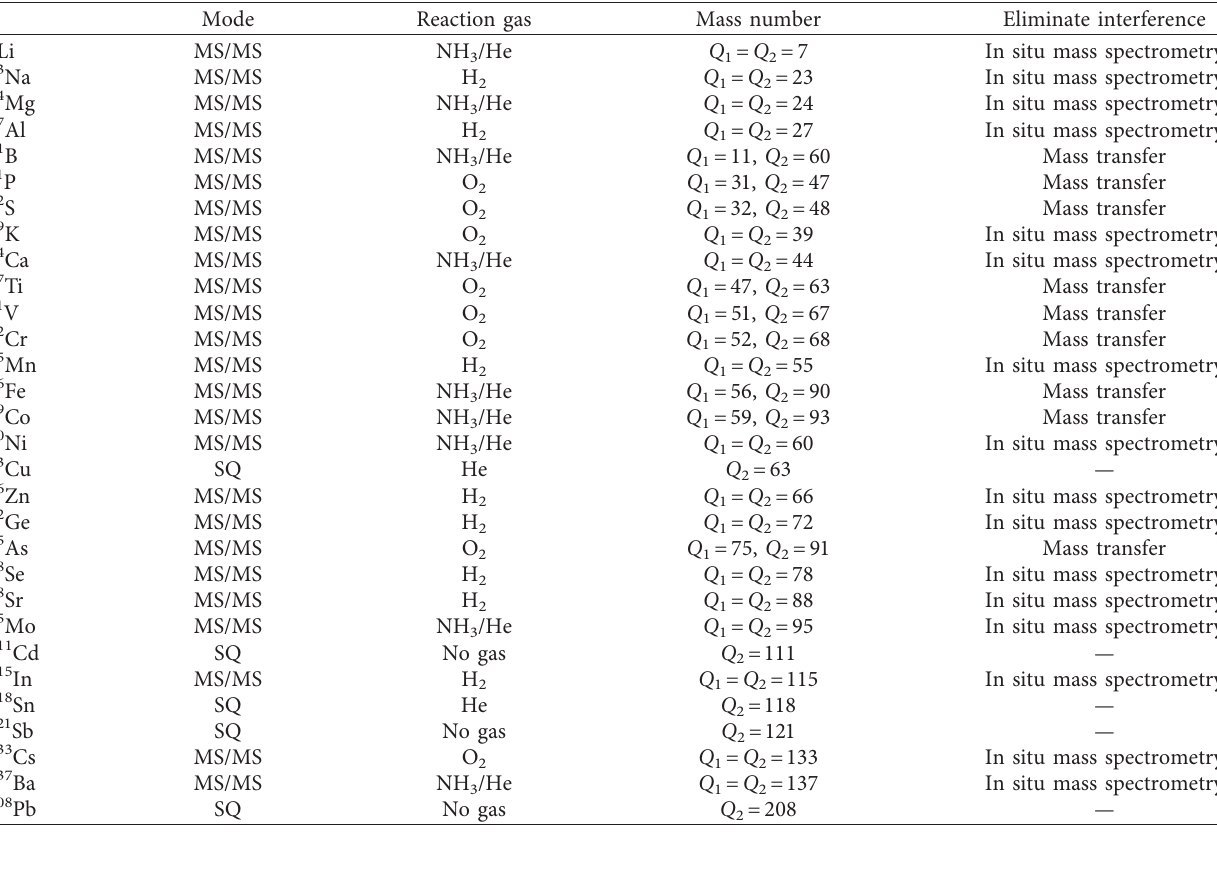
Table 4: Isotope mass spectrometry.